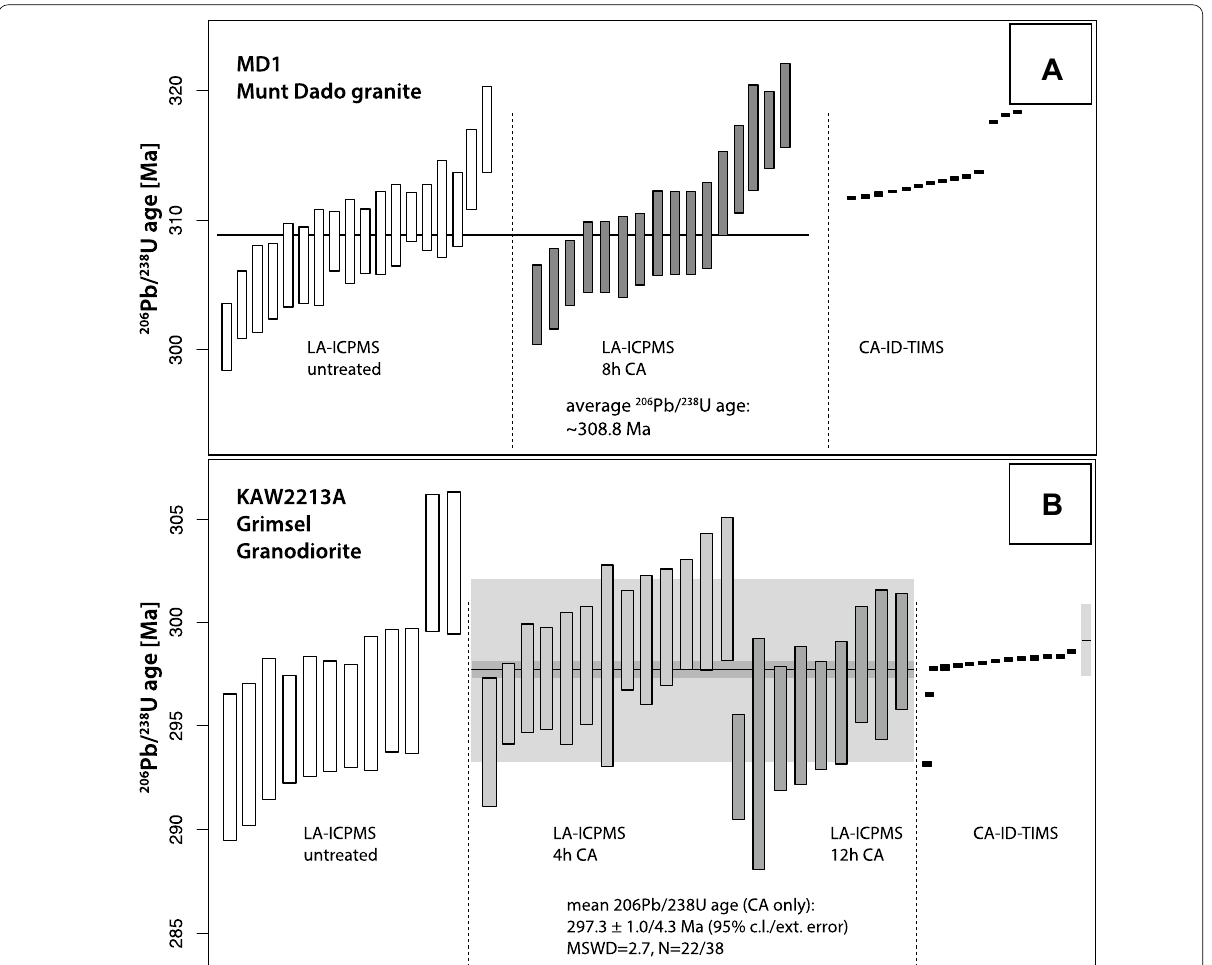
Fig. 8 Comparison of LA-ICPMS ages from both chemically abraded and untreated zircon, with ID-TIMS results from chemically abraded zircon for samples MD1 ( A ) and KAW2213A ( B ). ID-TIMS age and estimated uncertainty (grey bar) from Schaltegger & Corfu (1992) is indicated in ( B ) alongside the new CA-ID-TIMS